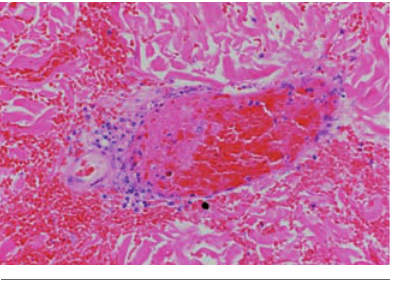
Figure 5. Dermal venous thrombus with acute inflammatory cell infiltration and endothelial cell damage (H&E stain, 400 ¥ magnification).